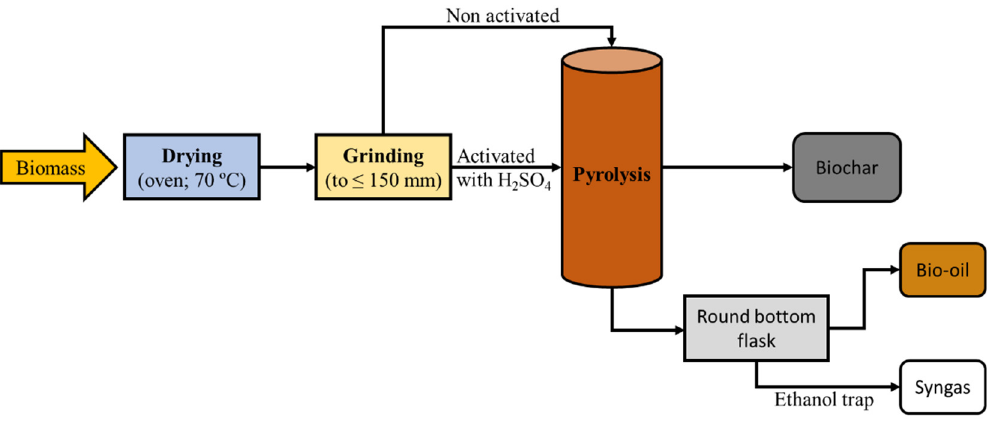
Figure 6. Process scheme for biomass pyrolysis. Between 5 g of OS pre-treated with H 2 SO 4 or 6 g of OS untreated were introduced into the reactor. The temperatures to which the samples were subjected for 2 h were 400, 500, and 600 °C, with heating ramps of 5, 10, and 20 °C ∙ min − 1 . Argon flow rates of 50, 150, and 300 mL ∙ min − 1 were used during the experiments (Table 6). Table 6. Pyrolysis conditions for olive stones (OS).